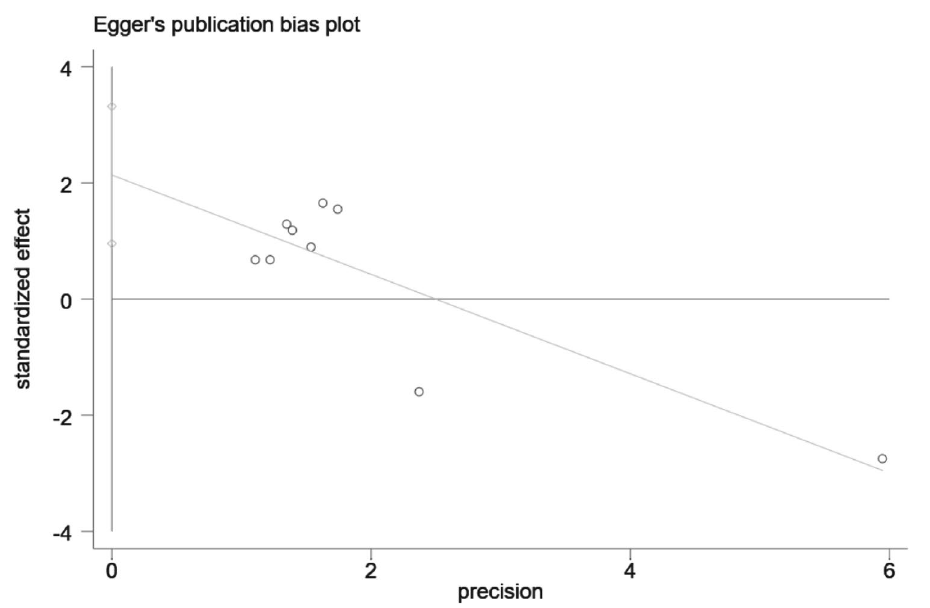
Figure 5. Egger’s test for publication